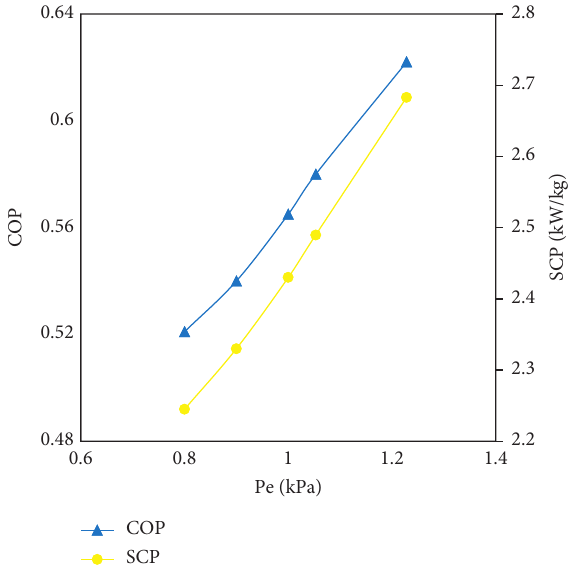
Figure 8: Variation of COP and SCP with P